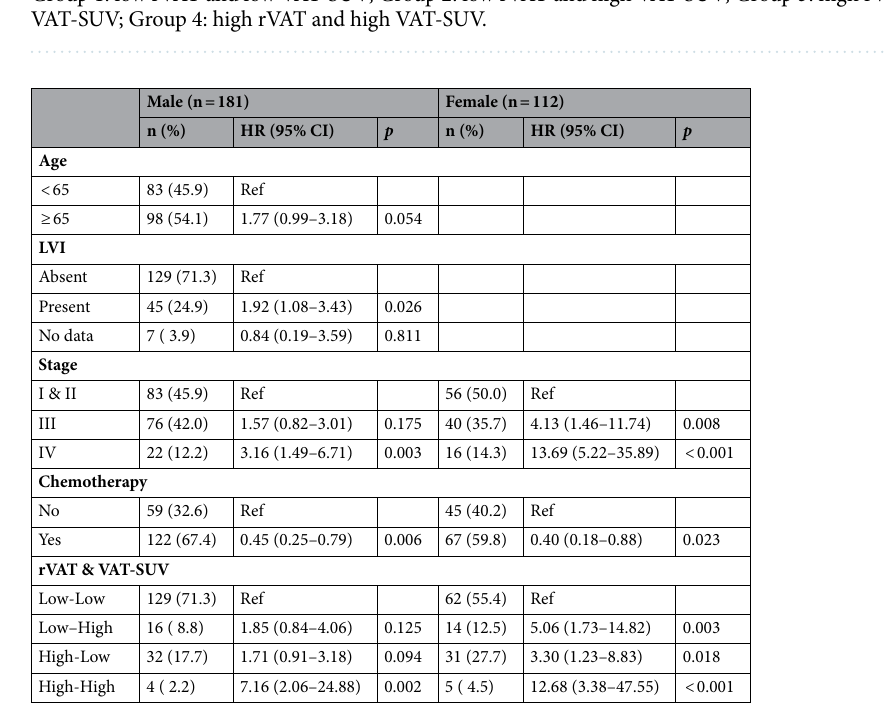
Table 4. Multivariate model using the combination of rVAT and VAT_SUV. BMI = Body mass index, CEA = Carcinoembryonic antigen, LVI = Lymphovascular invasion, rVAT = volume ratio of visceral adipose tissue (VAT) to total adipose tissue, SUV = Standardized uptake